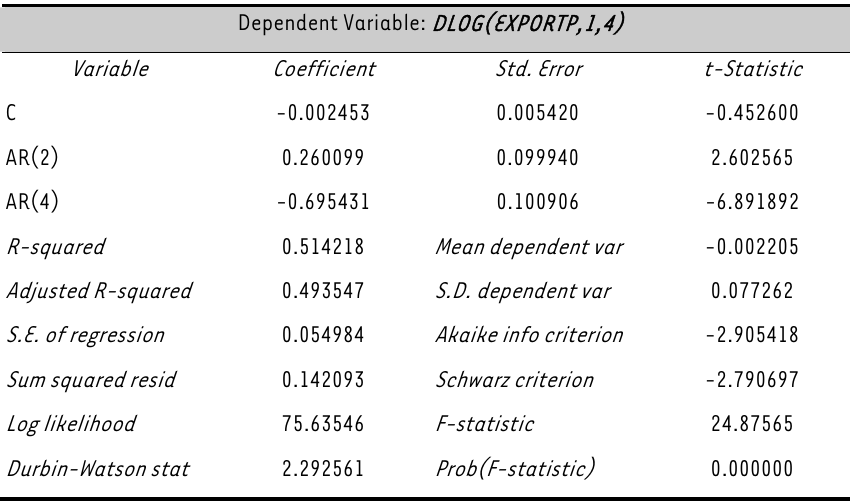
TABLE 6: Results of the Autoregressive Model for EXPORTP Dependent Variable: